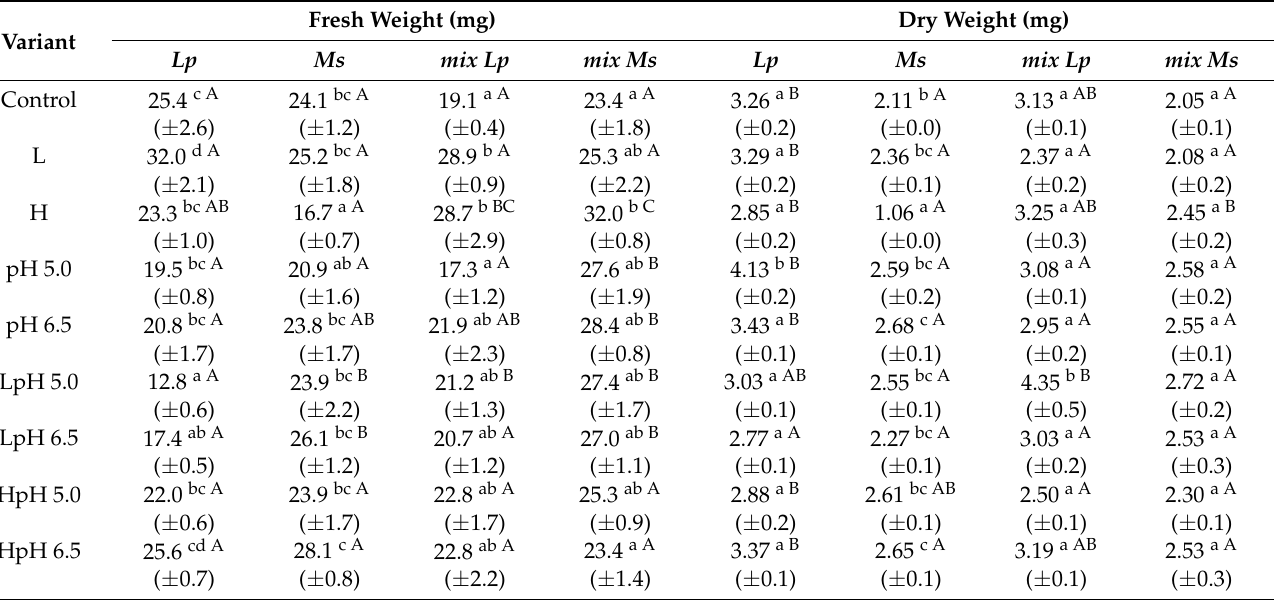
Table 8. Effects of different variants of Medicago sativa root extracts and pH of the solution on fresh and dry weight of Lolium perenne ( Lp ) and Medicago sativa ( Ms )